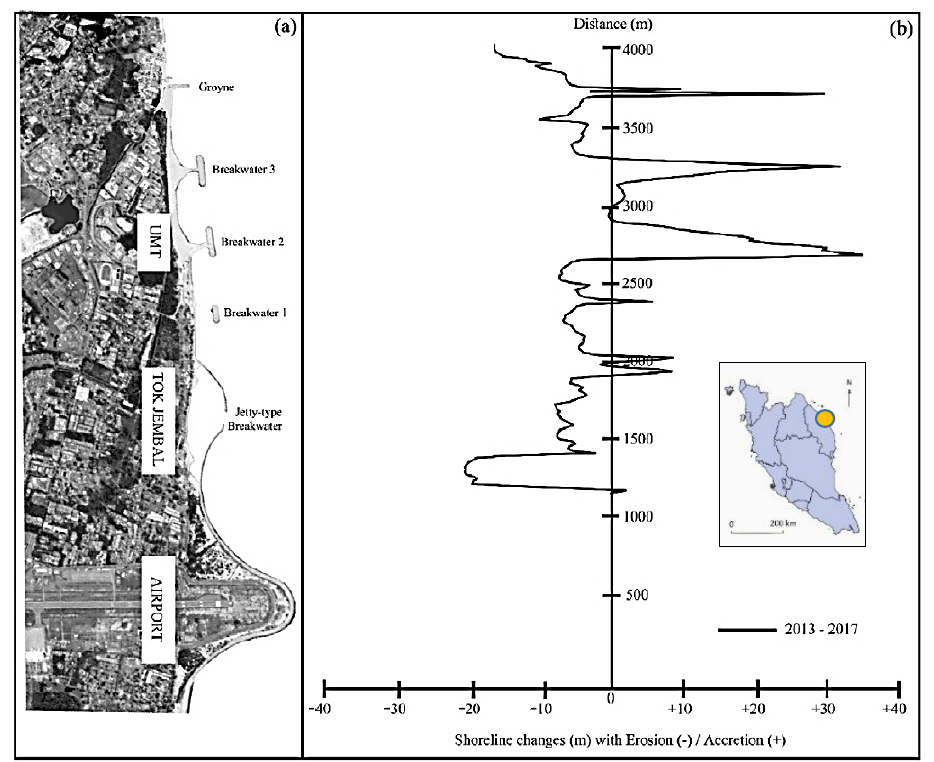
Figure 8. Shoreline changes along Kuala Nerus beach with ( a ) the current shoreline in 2017 and ( b ) erosion and accretion rates between 2013 and 2017 [83]. ‘Reproduced from [83] 2020; JSSM